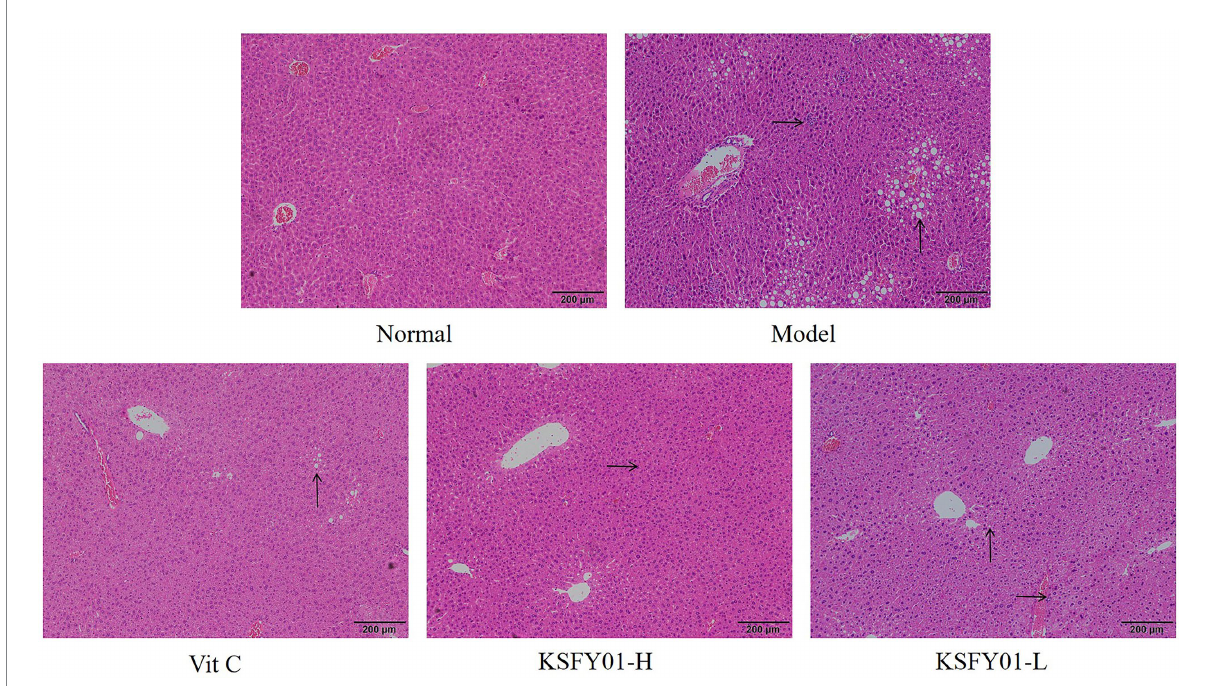
FIGURE 3 H&E pathological observation of liver tissue in aging mouse (magnification, ×100). Vit C, mice treated with vitamin C (200 mg/kg); KSFY01-H, mice treated with L. plantarum KSFY01 (1 × 10 10 CFU/kg); KSFY01-L, mice treated with L. plantarum KSFY01 (1 × 10 9 CFU/kg). → indicate adipocyte; ↑ indicate inflammatory cell in